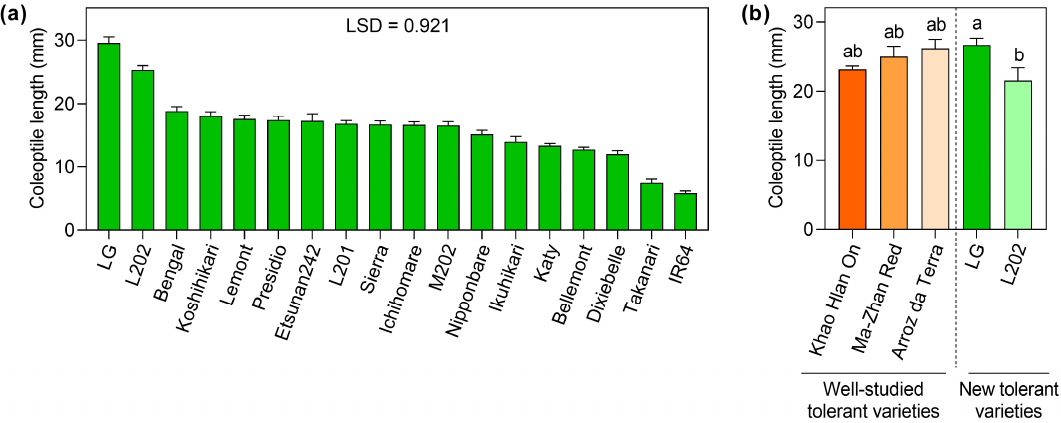
Figure 1. The distinct capability of rice accessions for coleoptile elongation under oxygen deficiency. ( a ) The coleoptile length of 18 rice varieties germinated under anaerobic conditions for 5 days under 12 h light and 12 h dark cycles. Data represent means ± SE ( n = 15). Multiple comparisons of means were performed using ANOVA followed by Fisher’s least significant difference (LSD) test. ( b ) Coleoptile elongation under oxygen deprivation in well-studied tolerant varieties vs. tolerant ones characterized in this study. Growth conditions used in ( b ) were identical to those in ( a ). Data represent means ± SE ( n = 20). Multiple comparisons of means were performed using ANOVA followed by Tukey’s honest significant test. Bars not sharing the same letter are significantly different ( p <